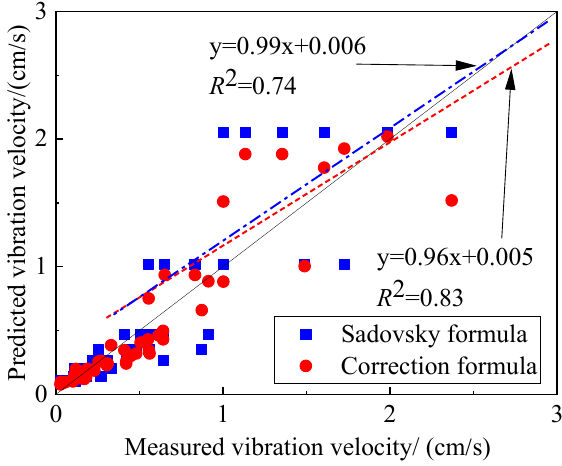
Figure 6. Formula validation.